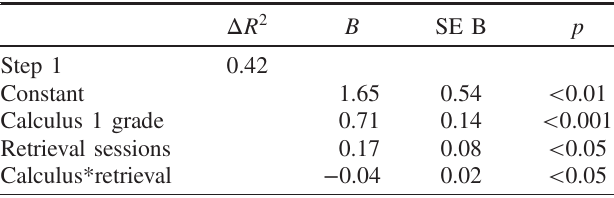
TABLE II. Multiple linear regression of Calculus 1 grade and retrieval sessions attended as predictors of exam grade, N ¼ 82